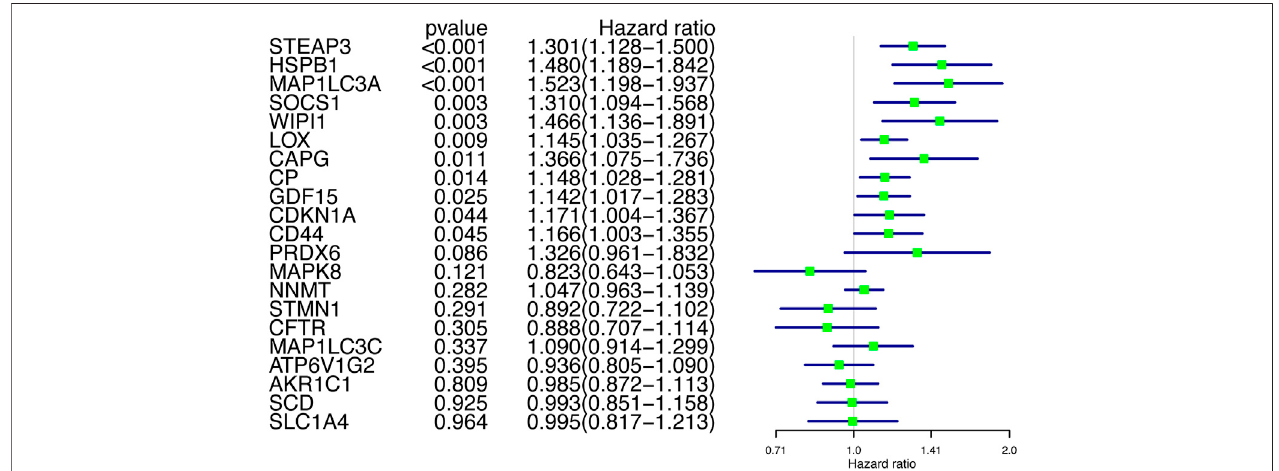
FIGURE 3 | Univariate Cox regression screening for prognosis-related